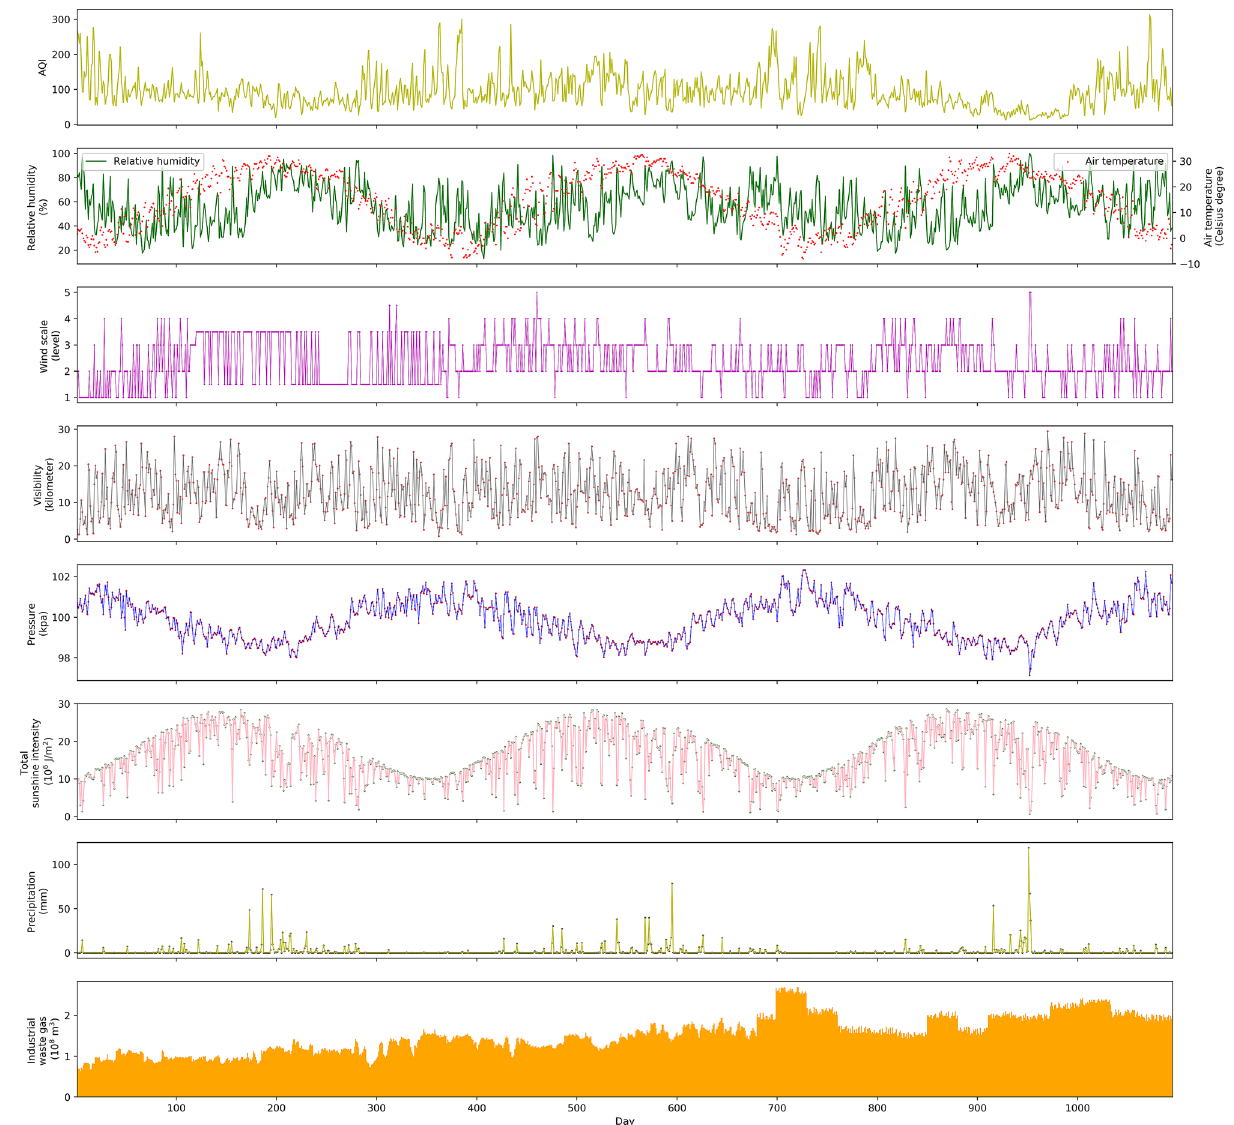
Figure 5. Trends of meteorological factors, industrial waste gas emissions, and AQI.